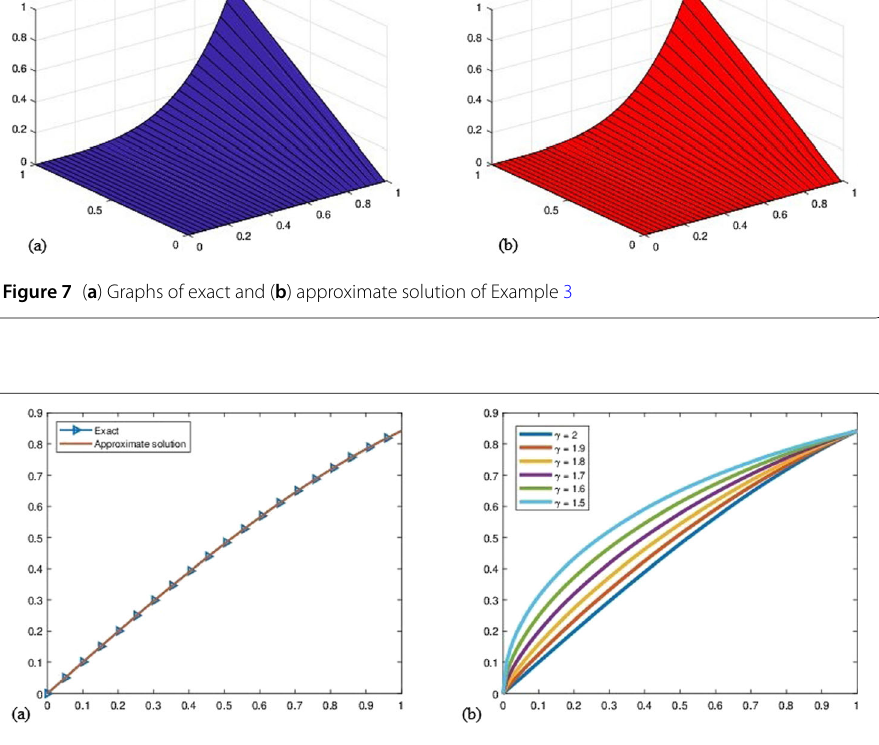
Figure 8 ( a ) Graph of exact and approximate solution and ( b ) different fractional-order results of γ of Example